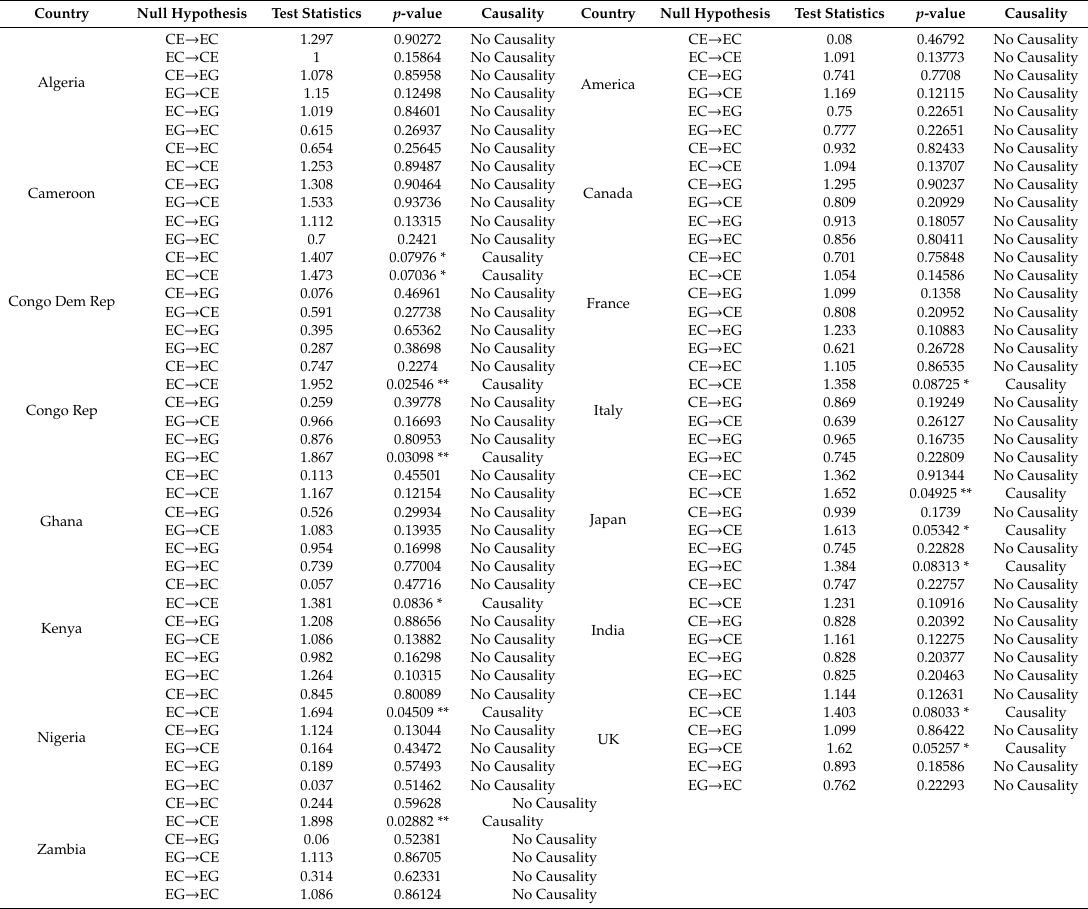
Table 11. Nonlinear Granger causality